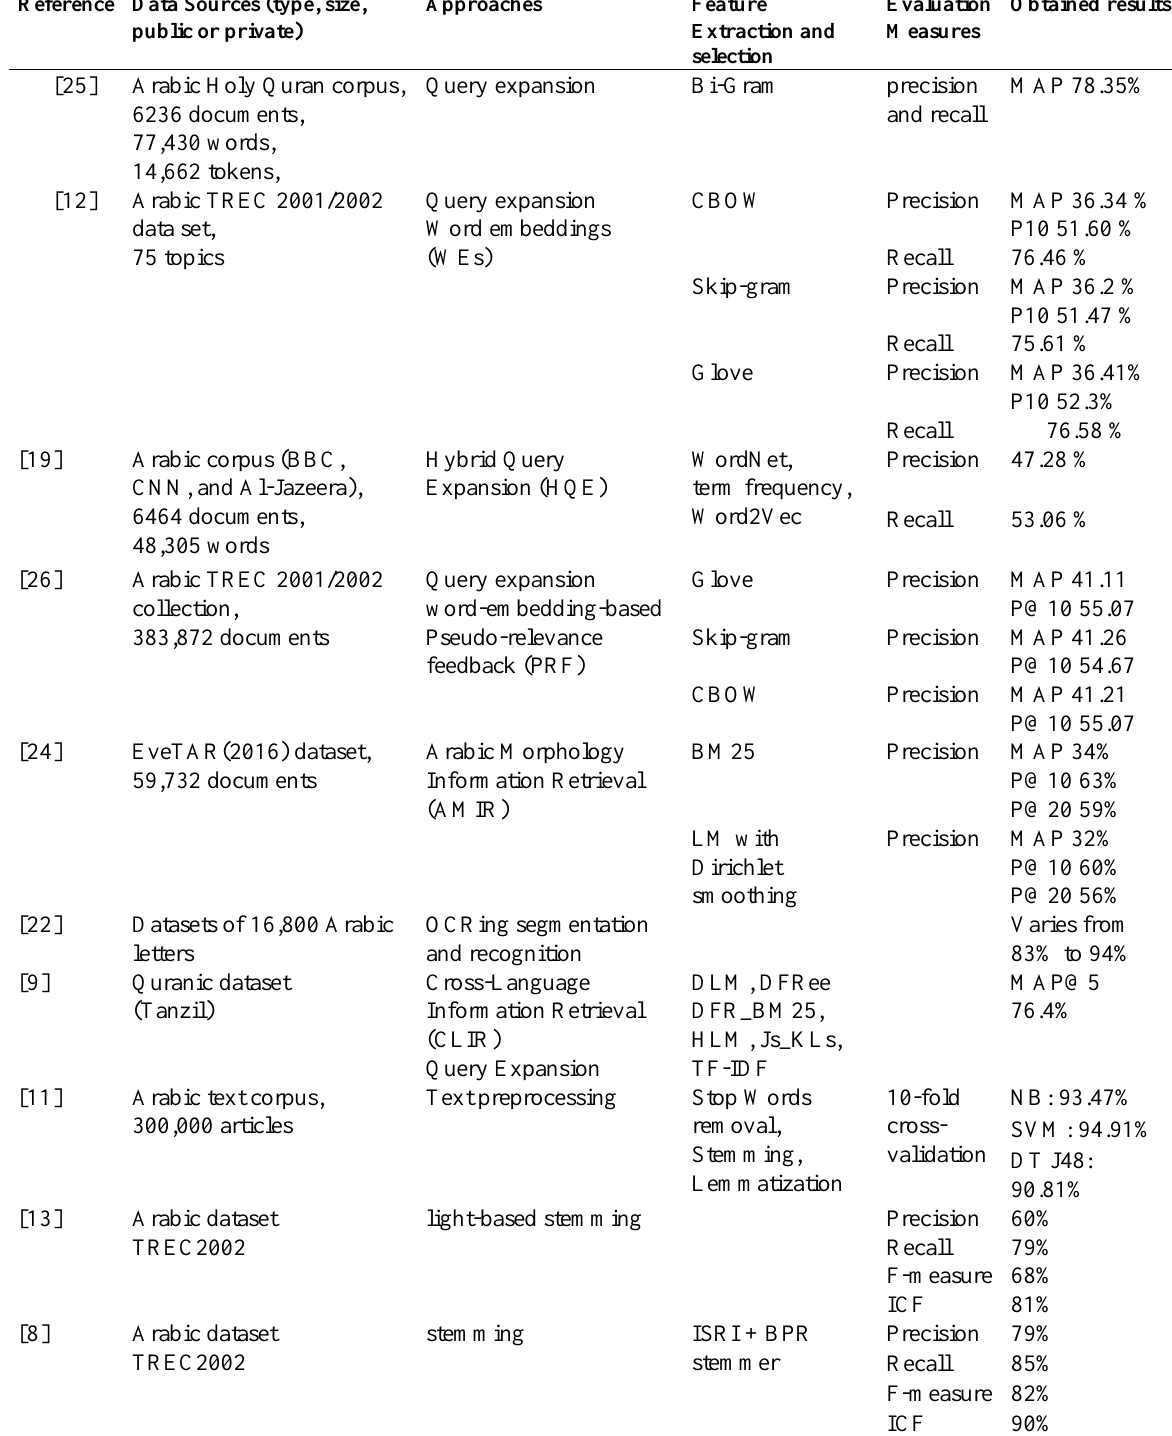
Table 1. Recent Arabic Information retrieval